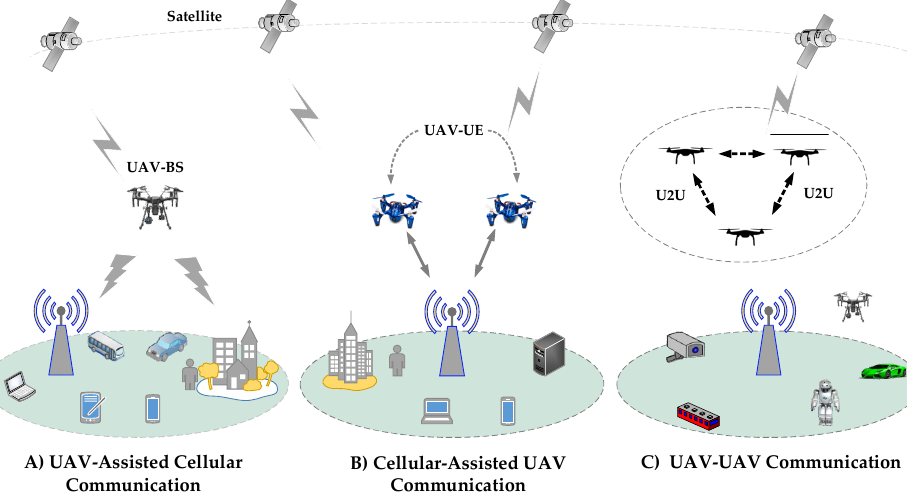
Figure 1. Drone system architecture, solutions, and integration in future mobile networks.